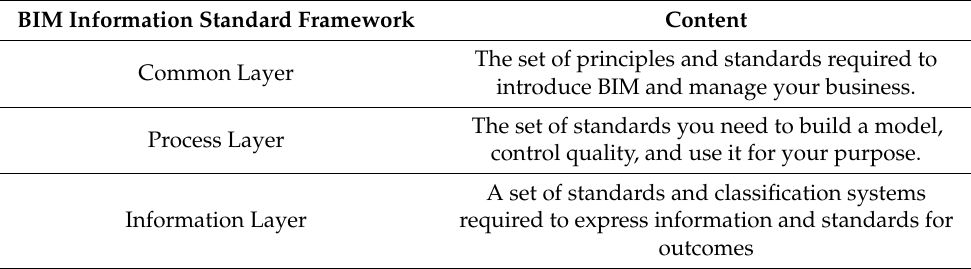
Table 5. Suggested standard framework for